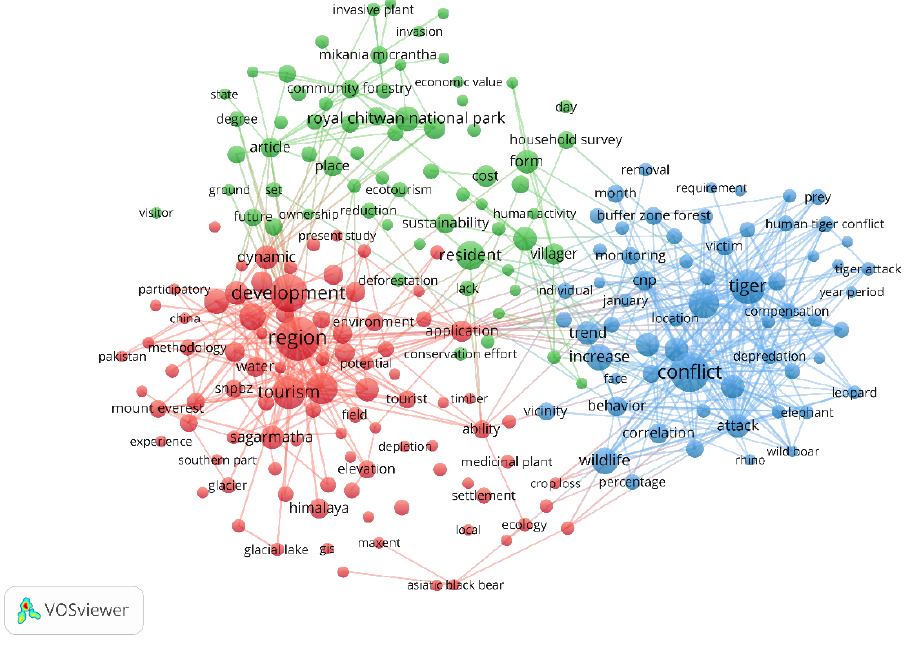
Figure 11. Mapping of “Buffer Zones”.